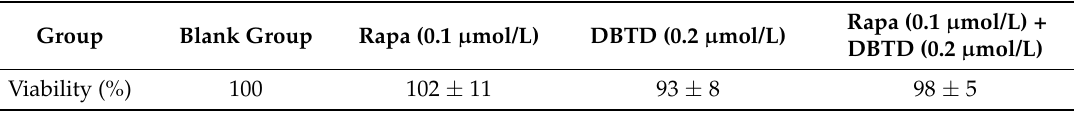
Table 3. Viability of cells treated with DBTD and rapamycin.